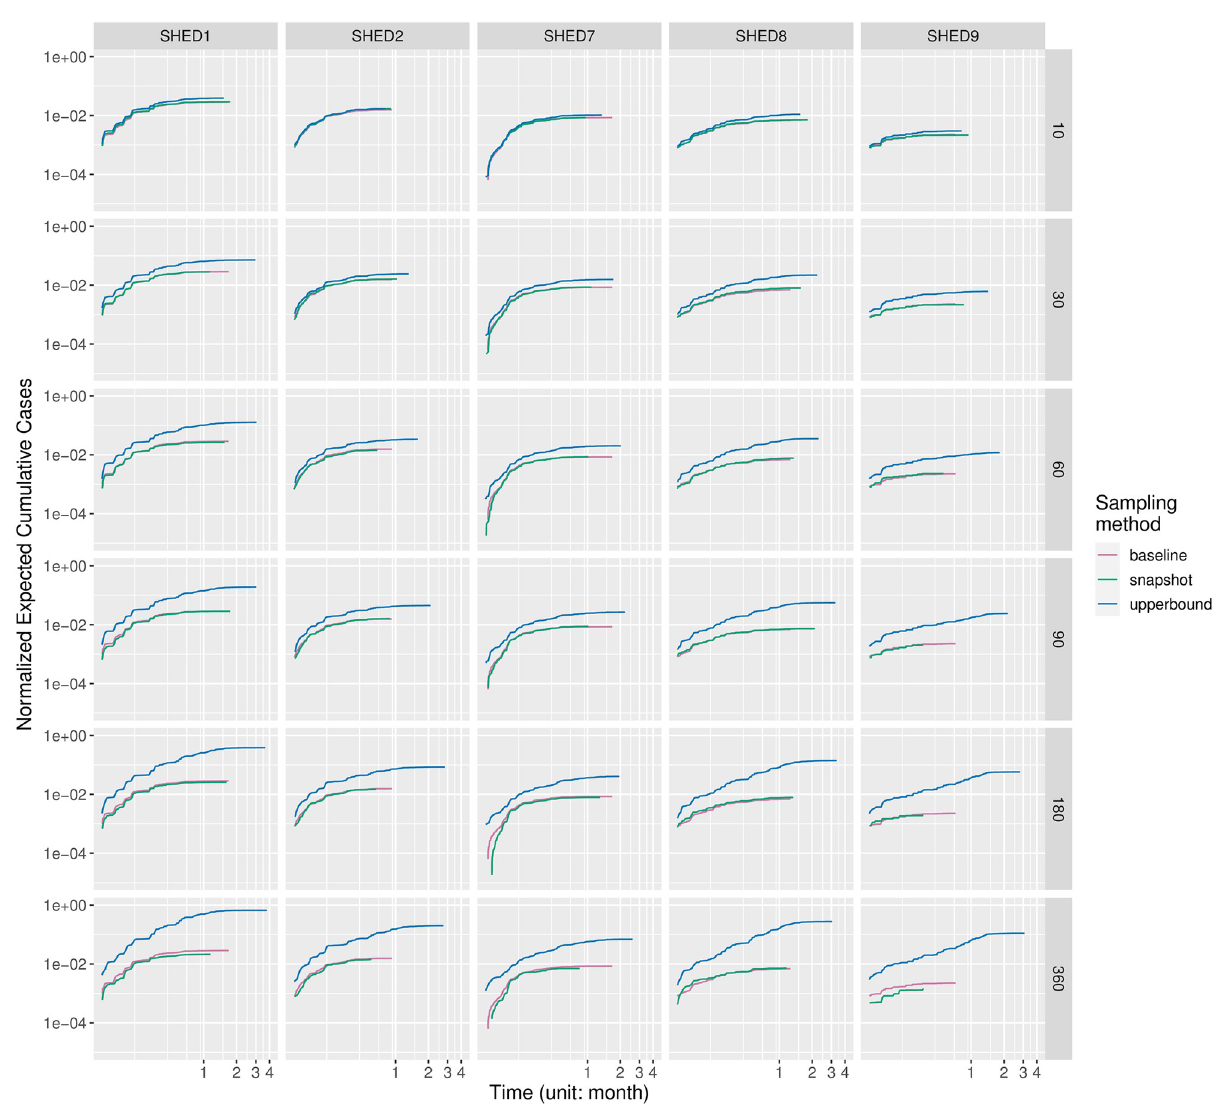
Fig 6. Outbreak timing of MERS. Figs 3–6 compares outbreak timing of diseases. The normalized expected cumulative cases (NECC) estimates the expected cumulative cases as a fraction of its underlying population size at time t , given the disease, underlying population, sampling method, and sampling interval. We organized NECC over time as colored curves in a grid of cells for each disease, with the underlying population in columns and sampling interval in rows. Each cell plots three NECC curves of the baseline (red), downsampled with the Snapshot method (green), and downsampled with the Upperbound method (blue). Each NECC curve plots NECC (y-axis) over time in the unit of months (x-axis). Both the x-axis and the y-axis are log 10 -scaled. The origin of each plot is at (0.5 weeks, 10 − 5 ). Minor ticks on the x-axis(lighter vertical strips) mark 1, 2, 3, and 4 weeks before the first month, then every half month (15 days). NECC curves have different periods (on the x-axis) because they either lack proximate contact from infectious to susceptible or run out of the susceptible. If a NECC curve ends early because of running out of susceptible, its NECC value will stop at one on the y-axis. Steeper NECC curves imply faster growth in cumulative cases. We selected four representatives here; the remainder can be found in the S1